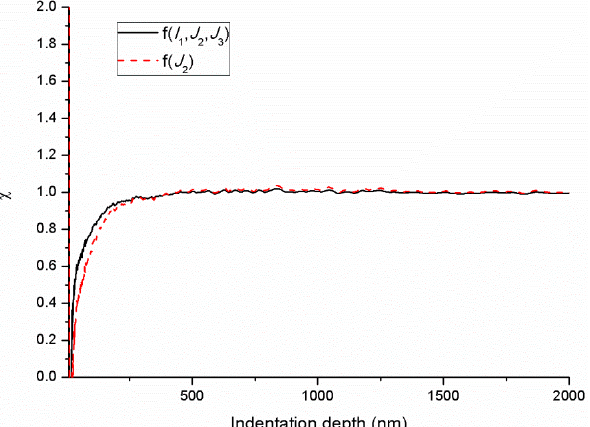
Figure 8. Comparison of the total probability χ of finding a fertile zone that can undergo shear transformation in the deformation zone with depth for different yield criteria of f ( J 2 ) and f ( I 1 , J 2 , J 3 ) .